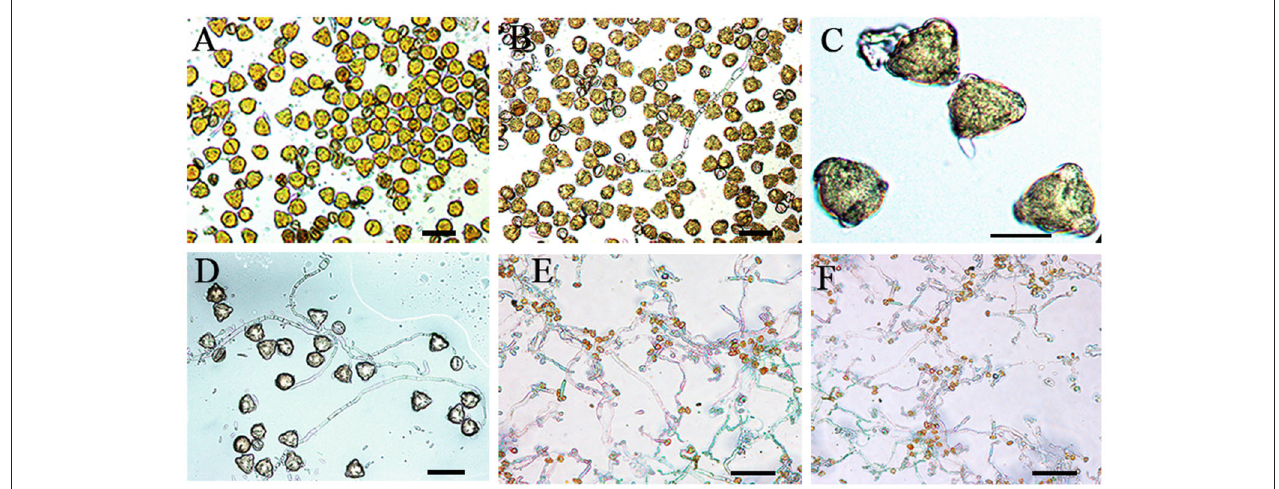
FIGURE 1 | Pollen germination after storage treatment. (A) Pollen germination of cv. Kožara at + 20 ◦ C (bar = 50 µ m), at + 4 ◦ C (B) (bar = 50 µ m), at − 80 ◦ C ( C ) (bar = 20 µ m) after 6 months. (D) Fresh pollen germination of cv. Budimka at + 20 ◦ C (bar = 50 µ m). (E) Pollen germination of cv. Budimka on − 20 ◦ C and on − 80 ◦ C ( F ) after 6 months (bars = 100 µ m).